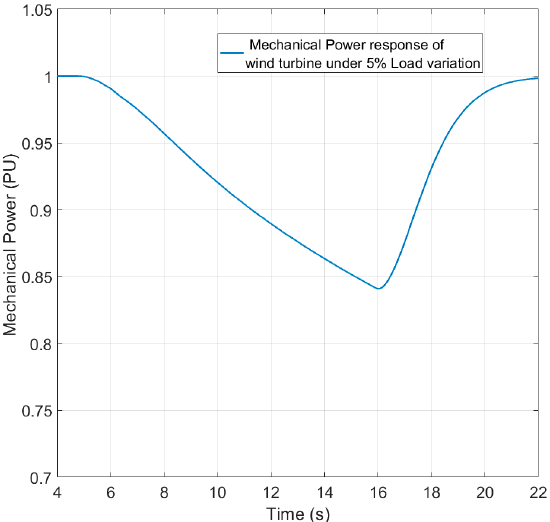
Figure 16. Response of WG1 during the extraction of kinetic energy: Variation of mechanical power.